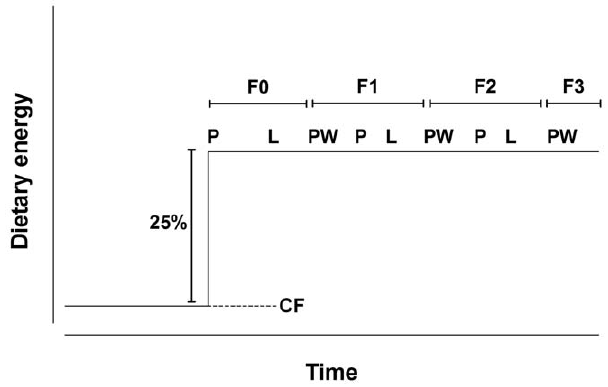
Figure 1. Experimental design. After conception in F0 dams, the energy content of the diet was increased by approximately 25% compared to the chow diet fed in the breeding colony. The energy content of the diet did not differ between generations during pregnancy (P), lactation (L) and to the offspring after weaning (PW).